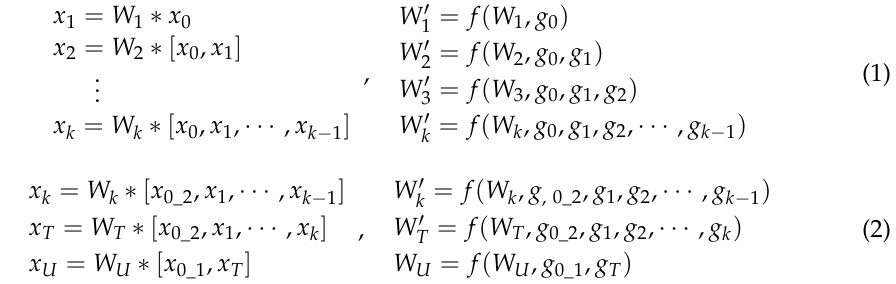
Figure 9. Structures of DenseNet and CSPNet (CSP-DenseNet). The CSPNet, which was proposed to solve this problem, adopted the convolution method by dividing the output of the previous layer, as shown in Figure 9b. Its advantage is that it can be applied without changing the backbone structure of most classical CNNs. Equations (1) and (2) are used to update the gradient during the layer feedforward calcu- lation and backpropagation of the DenseNet and CSPNet, respectively.